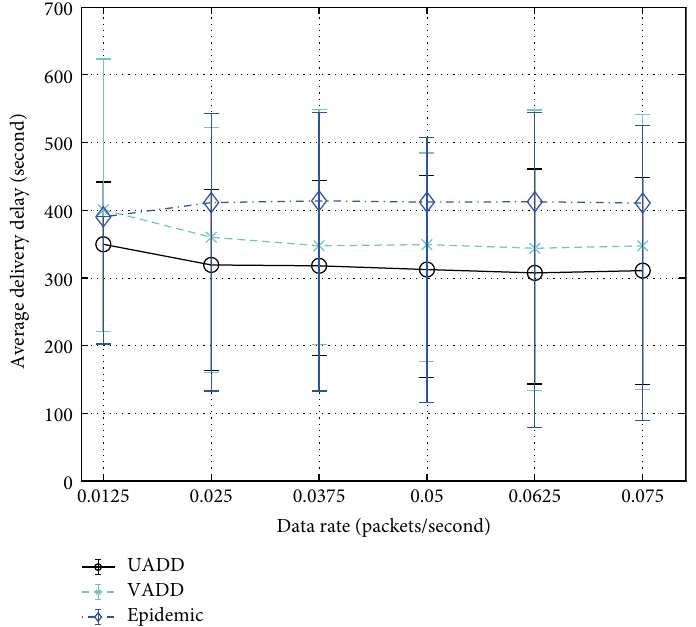
Figure 9: Average delay with